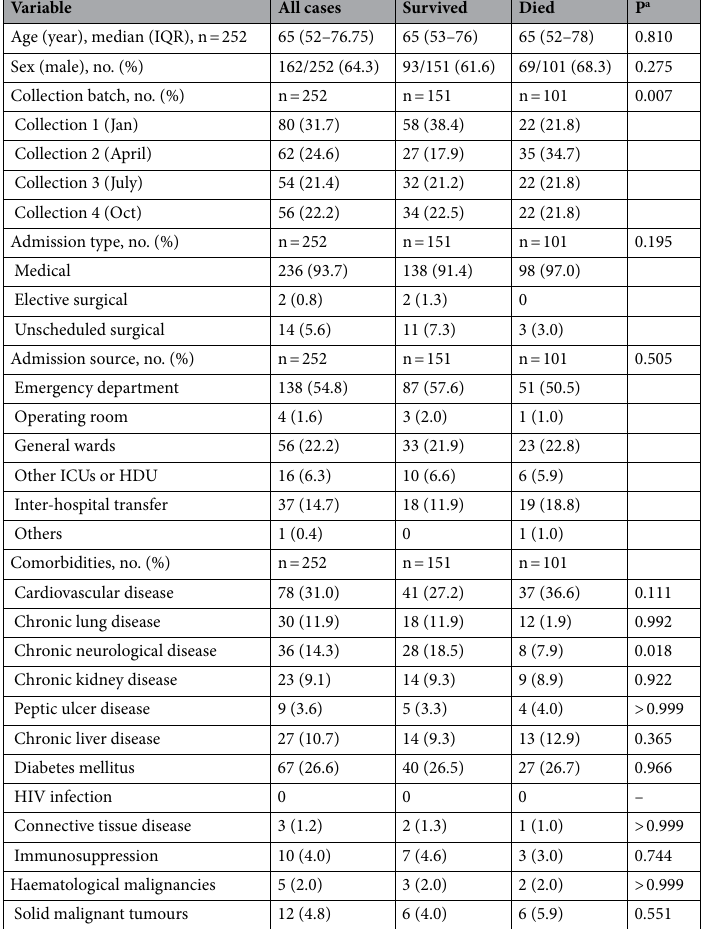
Table 2. Baseline characteristics according to hospital survivability of patients with sepsis. HDU high dependency unit, ICU intensive care unit, IQR interquartile range, no. number. a Comparison between survived and died patients with